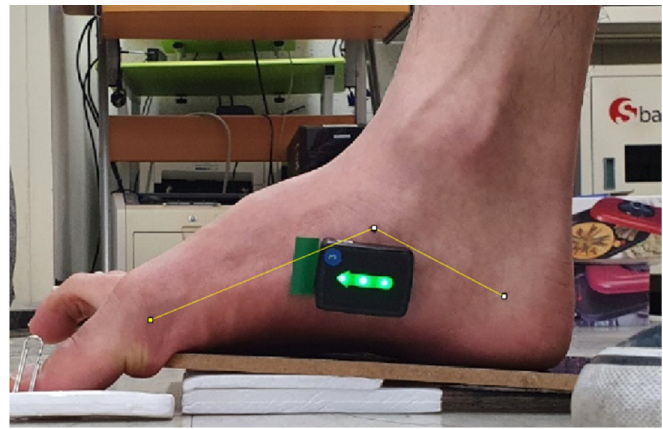
Figure 1. Measurement of the medial longitudinal